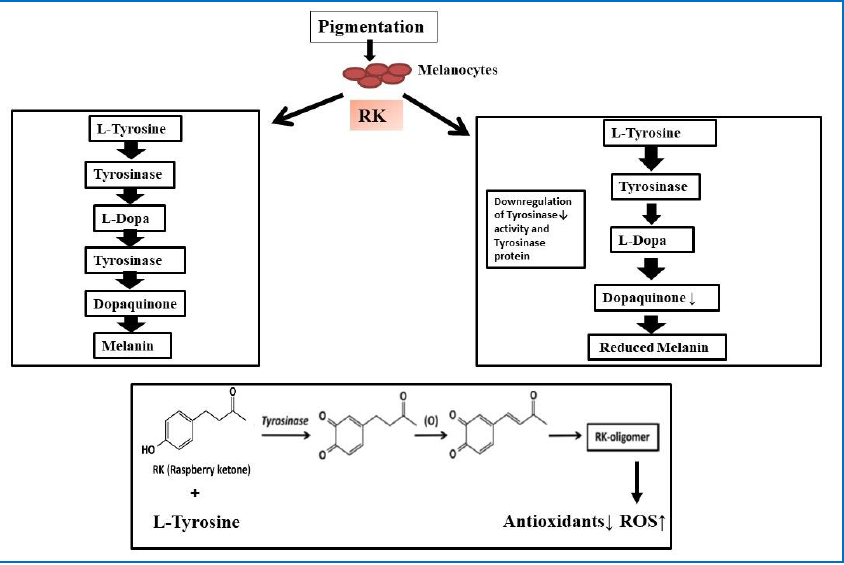
Figure 5. The schematic diagram showing the production of melanin from melanocytes and the effect of RK on melanin synthesis resulting in